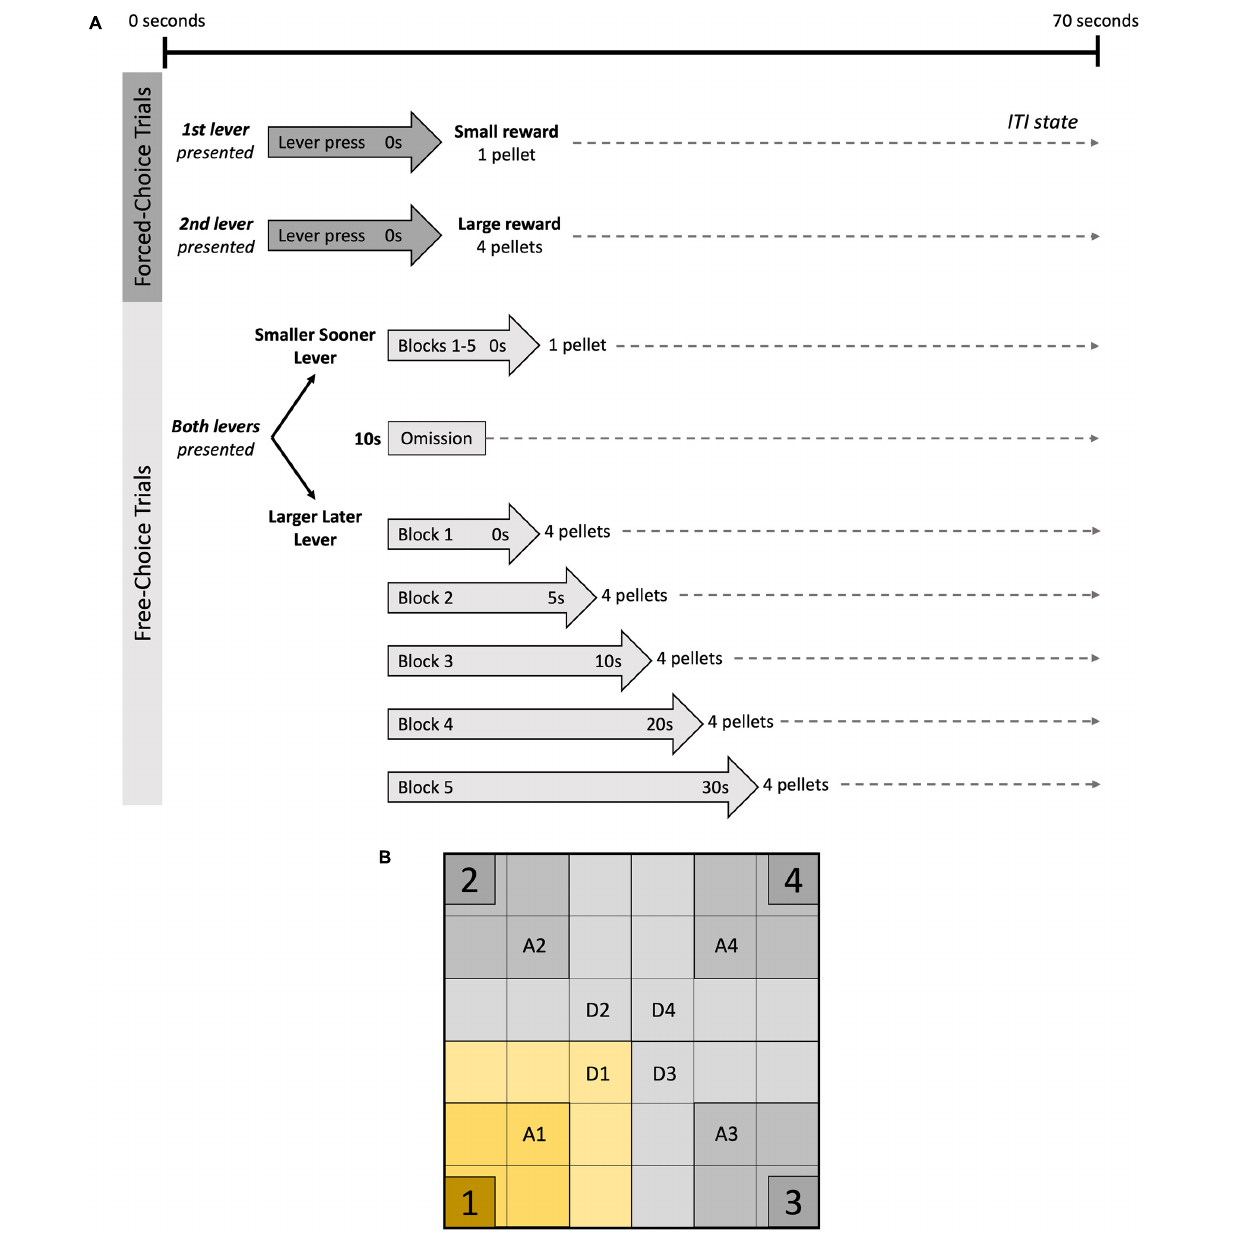
Frontiers in Behavioral Neuroscience |